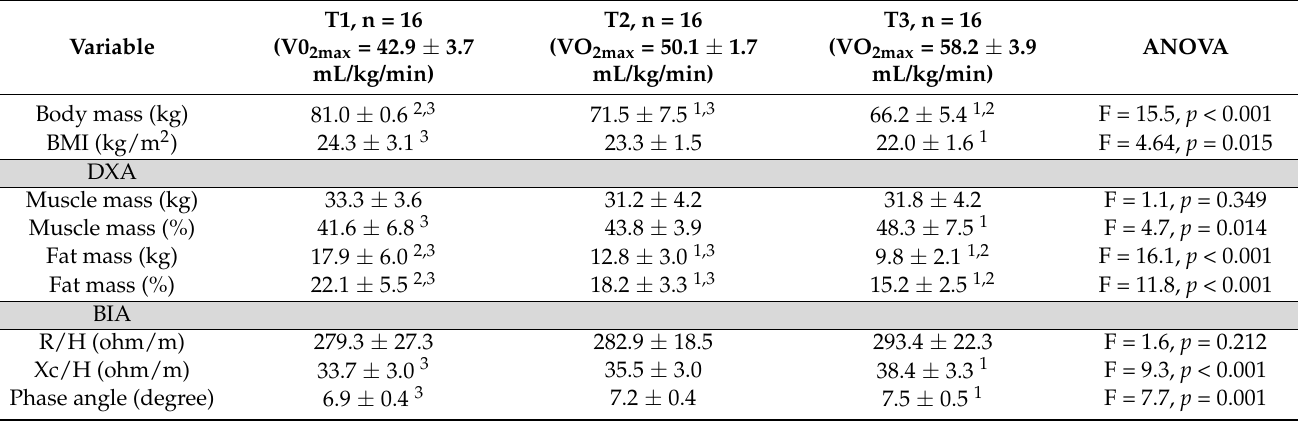
Table 1. Body composition characteristics (mean ± standard deviation) for the athletes grouped by tertiles of VO 2max and results of the analysis of variance (ANOVA) are shown.